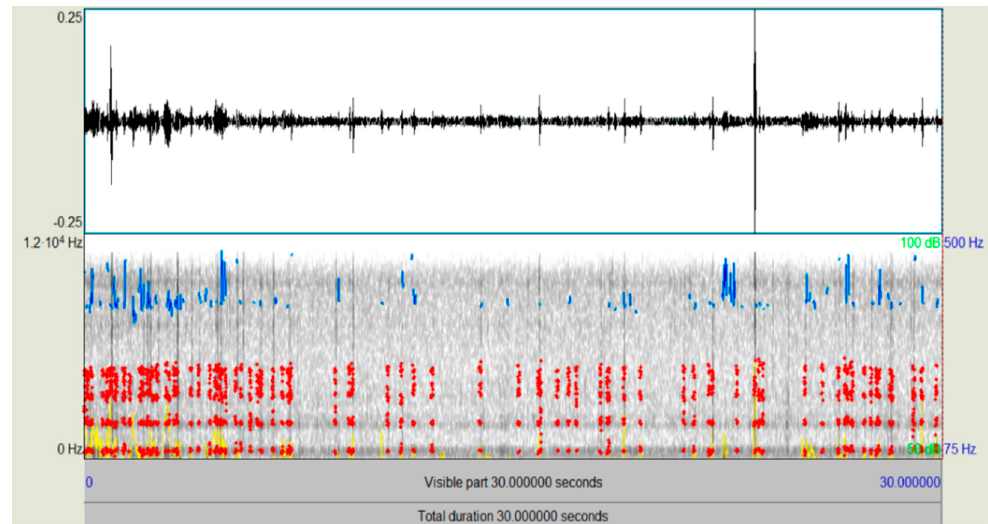
Figure 5. Spectrogram of the audio signal “Moderate rain”. Table 4. Formants, intensity and pitch parameters of “Moderate rain” audio signal.